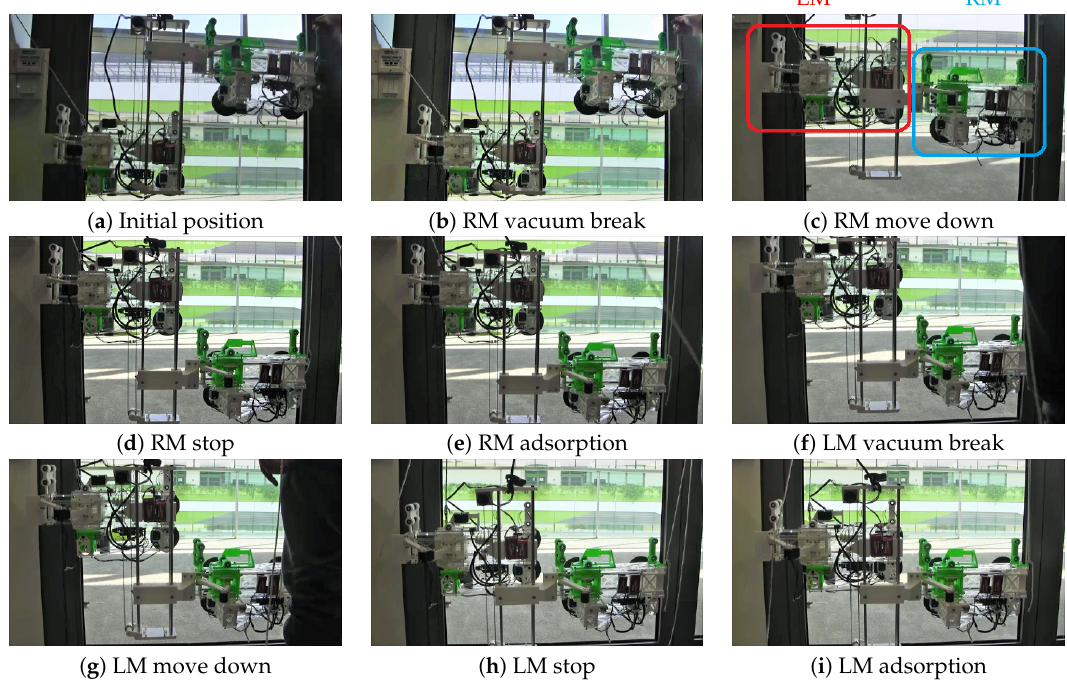
Figure 14. The snapshots of the experiment. RM and LM represent Right module and Left module, respectively. The experiment start form initial position ( a ). First, the vacuum of RM is broken ( b ), and is moved down ( c ) to bottom ( d ). After that, RM engages adsorption on the glass surface ( e ). Secondly, the vacuum of LM is broken ( f ), and is moved down ( g ) to neighbor of RM ( h ). Finally, LM engages adsorption on the glass surface ( i ) and the experiment is